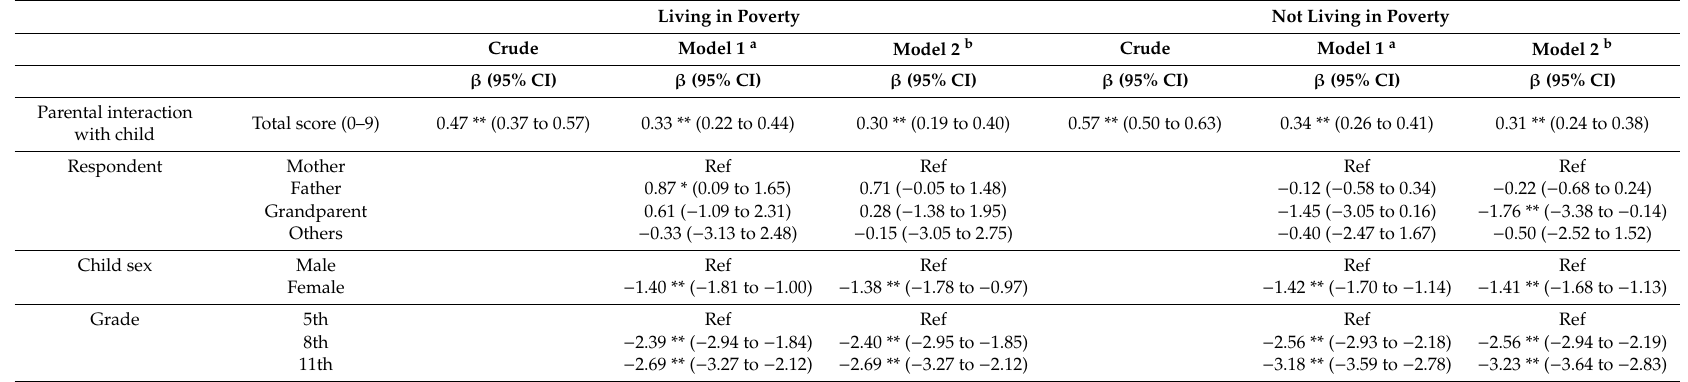
Table 4. The association between total number of parental interactions with child and self-esteem among adolescents living in poverty ( n = 3696) and not living in poverty ( n =